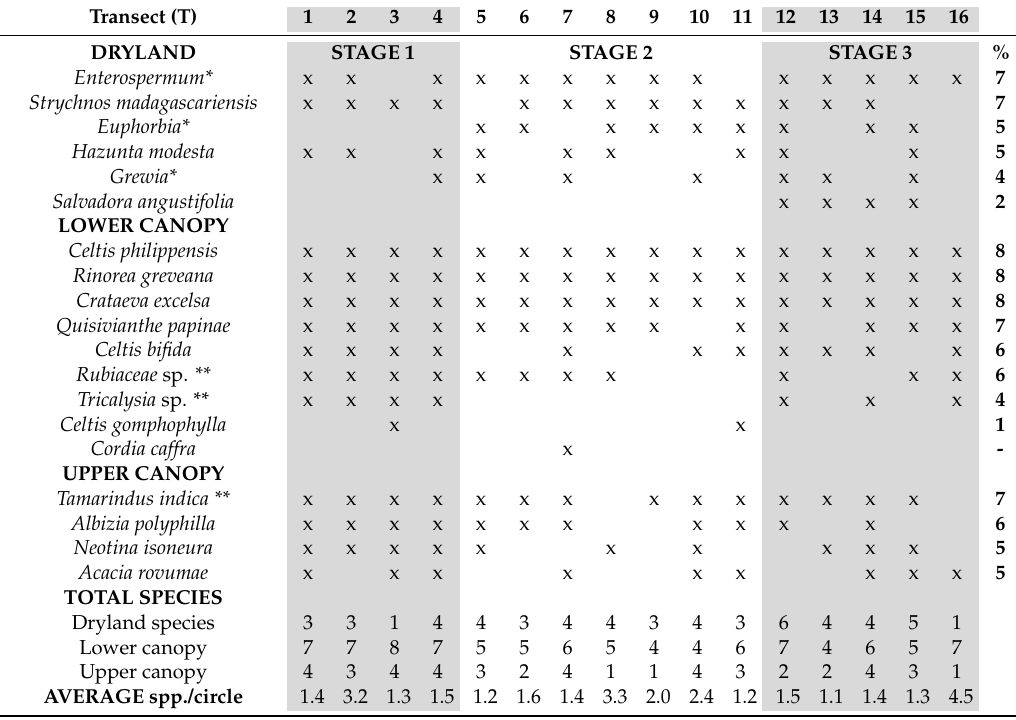
Table 2. Transect tree species classified according to habit and habitat. Short transects are highlighted.